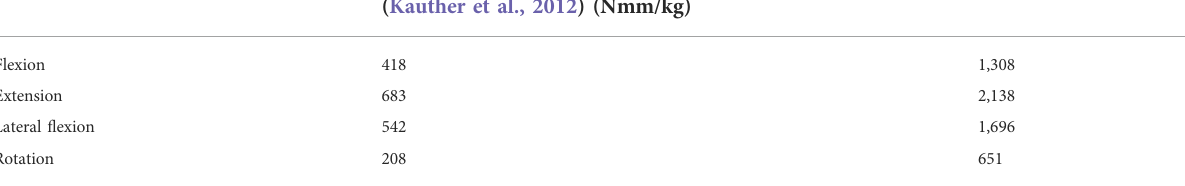
TABLE 5 Torque applied under different loading